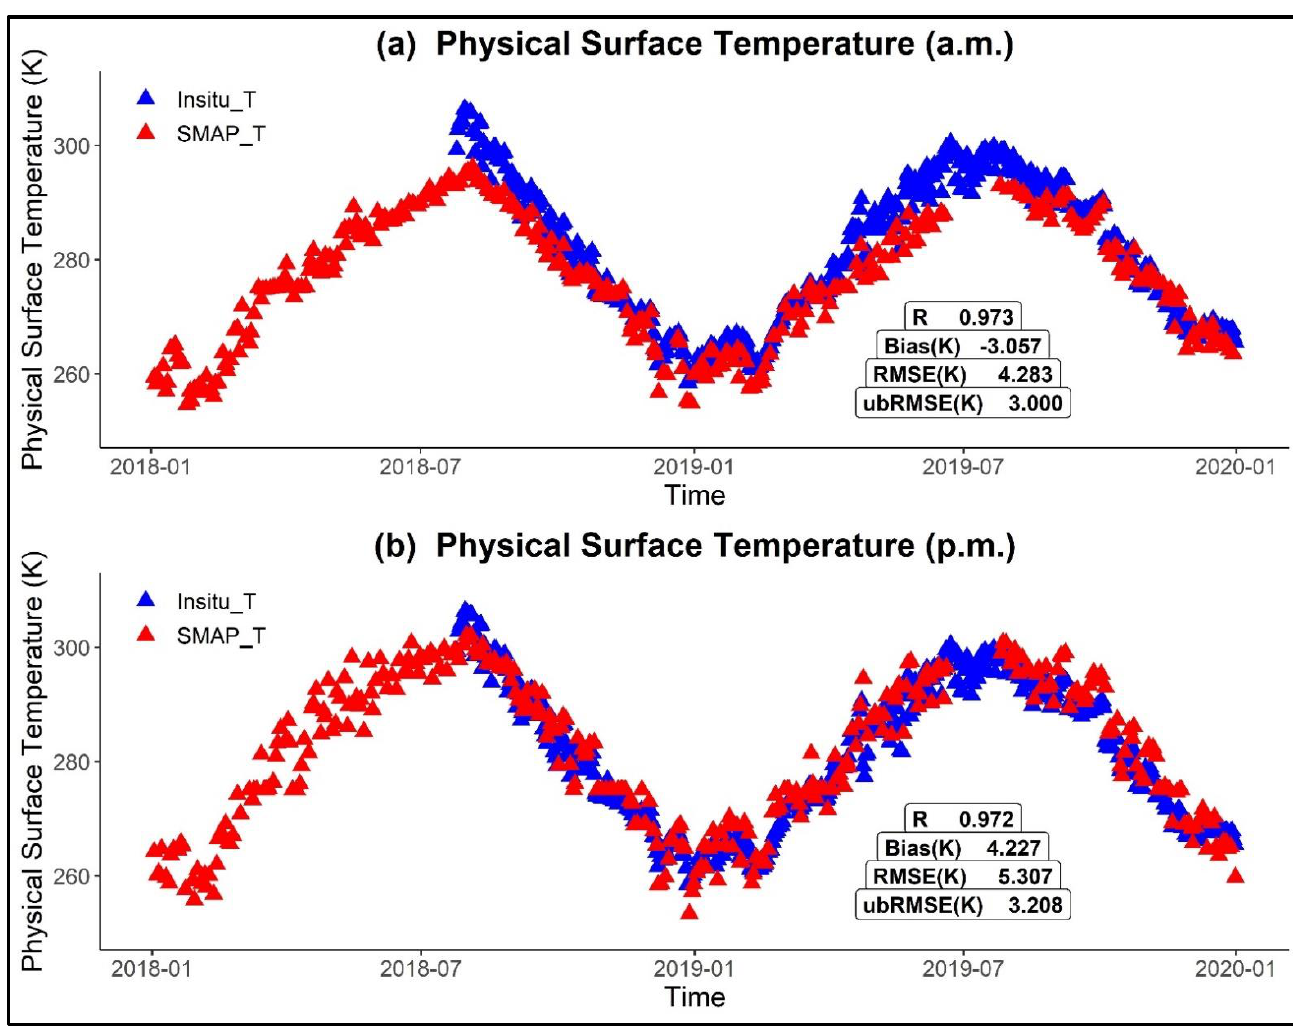
Figure 13. Time-series of averaged in situ T and SMAP T for the ( a ) a.m. and ( b ) p.m. orbits in the assessment domain.